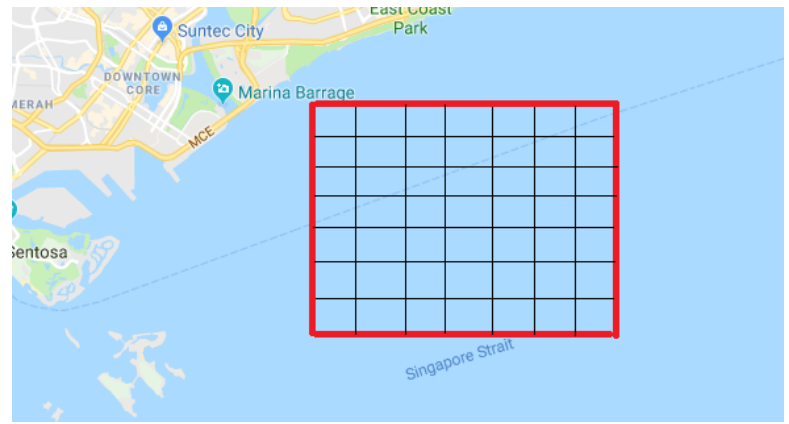
Figure 5. The Selected Marine Area: 7 × 7